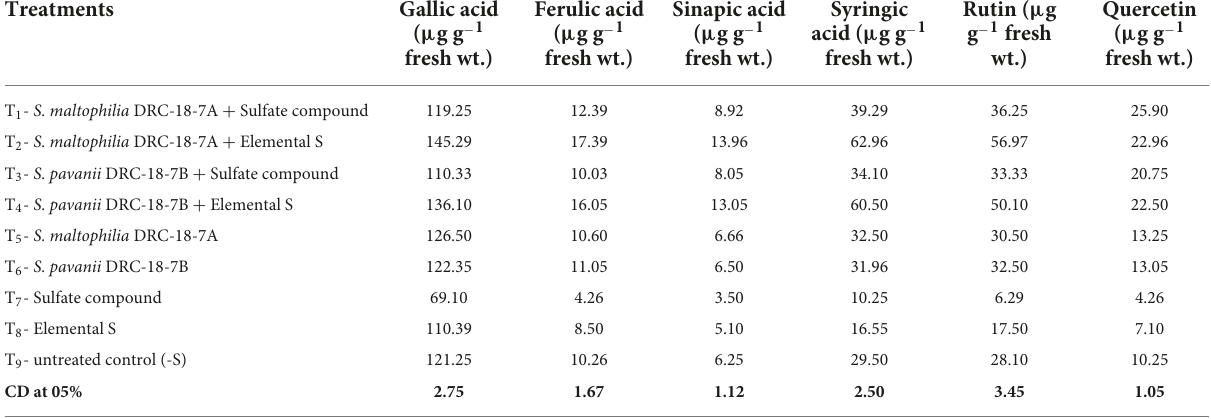
TABLE 3 Effects of inoculation on individual phenolic and flavonoids content in pigeonpea leaves at 30 days of sowing under glasshouse